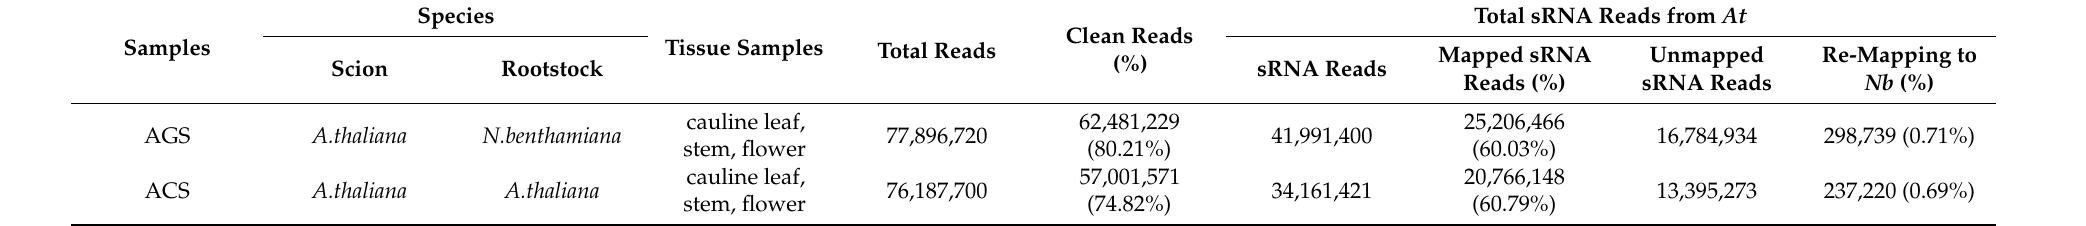
Table 1. Deep sequencing of small RNA libraries from the At scion and mapping to the At and Nb genomes.